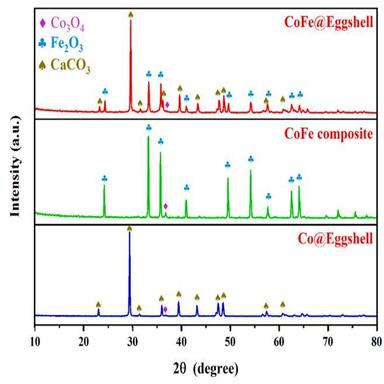
The XRD images of CoFe@Eggshell, Co@Eggshell and CoFe composite.